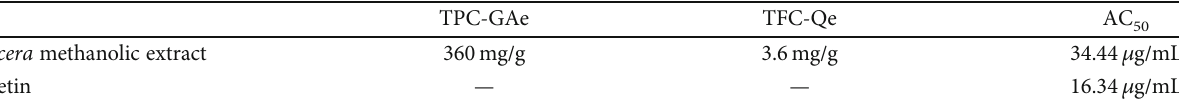
Figure 5: MPO activity in colonic tissue. Colons were resected after 10 days, processed, and the supernatants were recovered to measure the MPO activity. The data shown are the mean values for each group ( n = 6 ). ∗ represents signi fi cant di ff erences vs DSS group ( P < 0 : 0001 ) and vs Control group (one-way ANOVA). Table 1: Total phenolic and total fl avonoid contents and antioxidant capacity of the C. procera methanolic